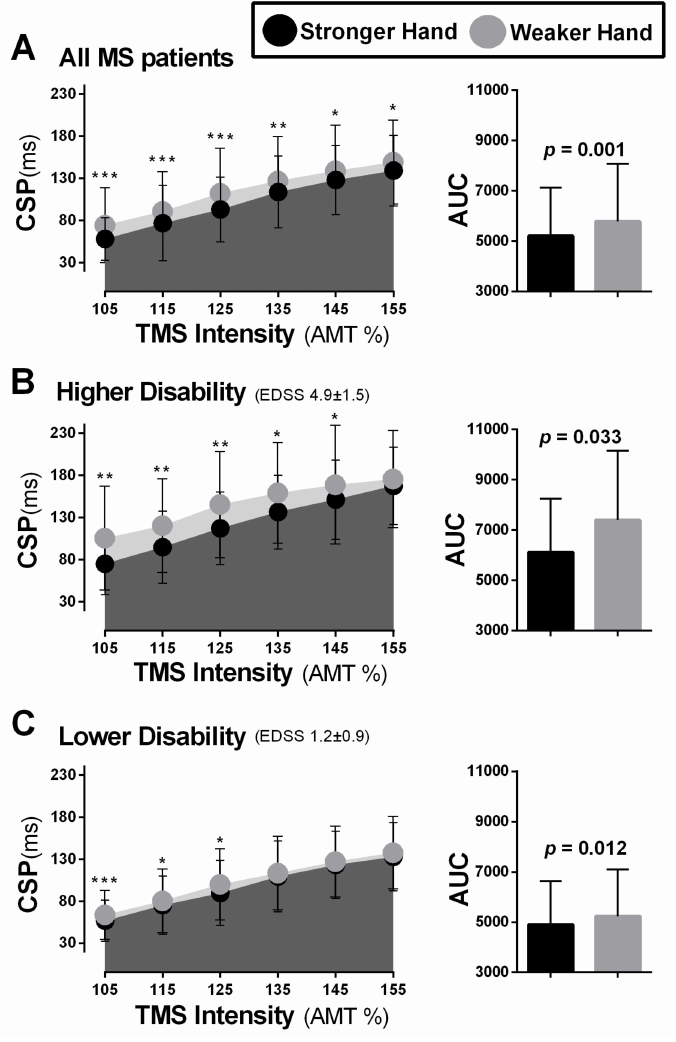
Figure 9. Differences in the Inhibitory Recruitment Curve (iREC). ( A ) With all participants in the same analysis, significantly longer cortical silent period (CSP) duration was noted in the hemisphere corresponding to the weaker hand compared to the stronger hand across all the iREC intensities. ( B ) In participants with a higher level of disability (EDSS) ≥ 3), CSP duration was significantly longer in the weaker compared to the stronger hand at TMS intensities of 105–145% of the active motor threshold (AMT). ( C ) In participants with a lower level of disability (EDSS < 3), CSP duration was significantly longer in the weaker compared to the stronger hand at the TMS intensities of 105–125% of AMT ( A – C ). In all participants, as well groups based on higher and lower level of disability, overall inhibition (AUC) was significantly higher in the weaker compared to the stronger hand. ***, p < 0.001, **, p < 0.010, *, p < 0.050. Error bars represent one standard deviation ( ± SD) of the data mean. EDSS, expanded disability status scale (MS severity; 0 = no disability, to 10 = death due to